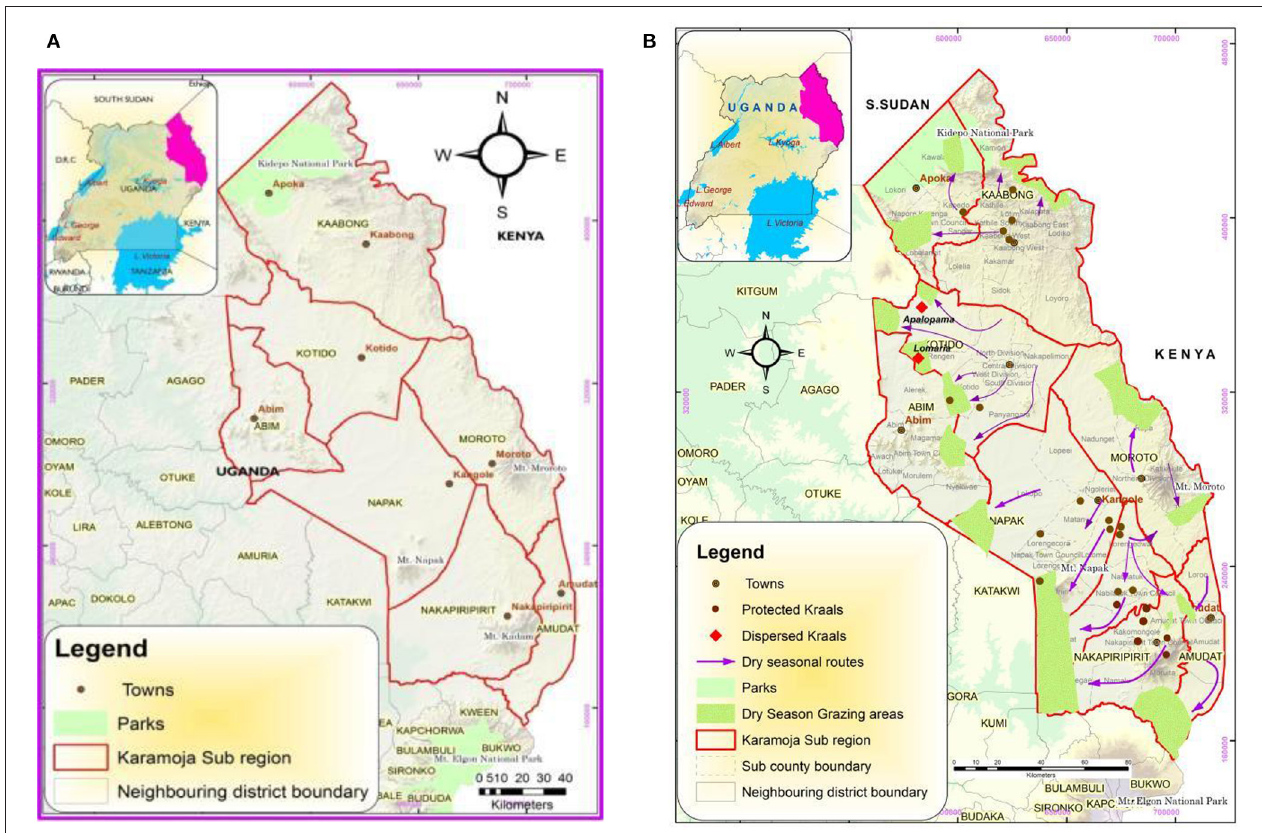
FIGURE 1 | (A) Location of Karamoja sub-region. (B) Dry season grazing areas and transhumance routes in Karamoja